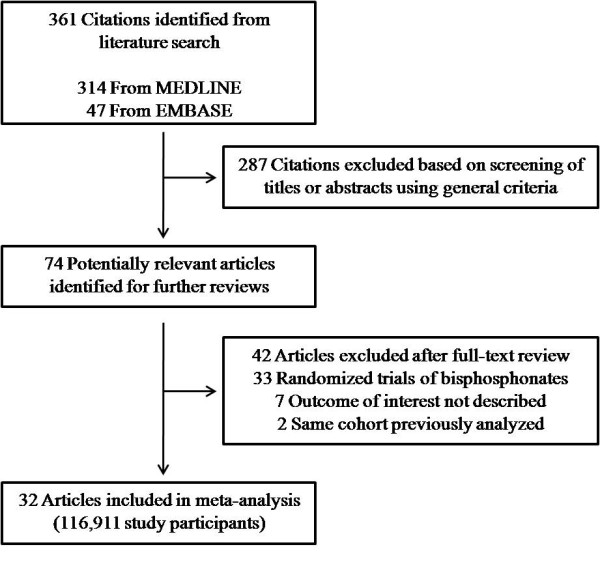
Flowchart of the meta-analysis.